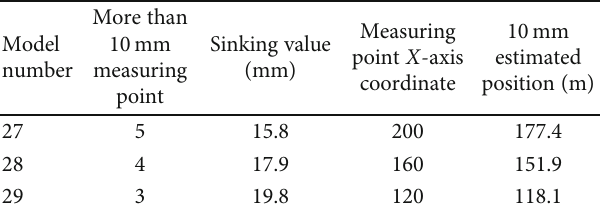
Figure 18: Boundary angle calculation diagram. Table 3: Sinking 10 mm position.